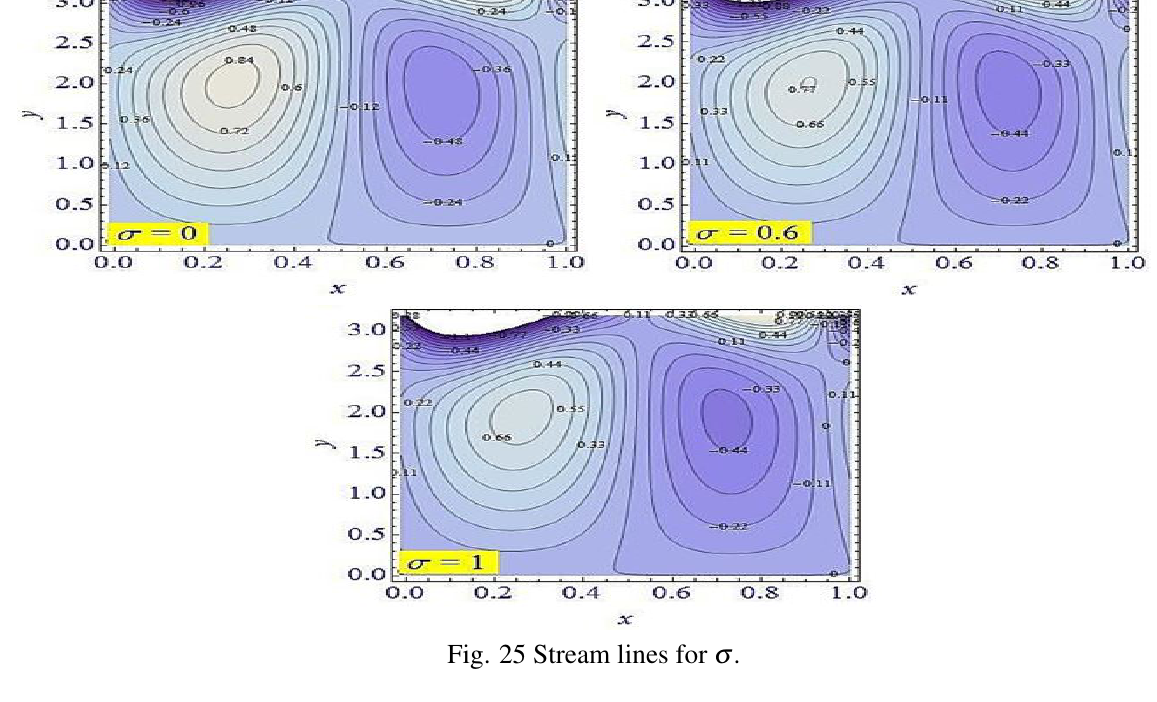
Fig. 25 Stream lines for σ .